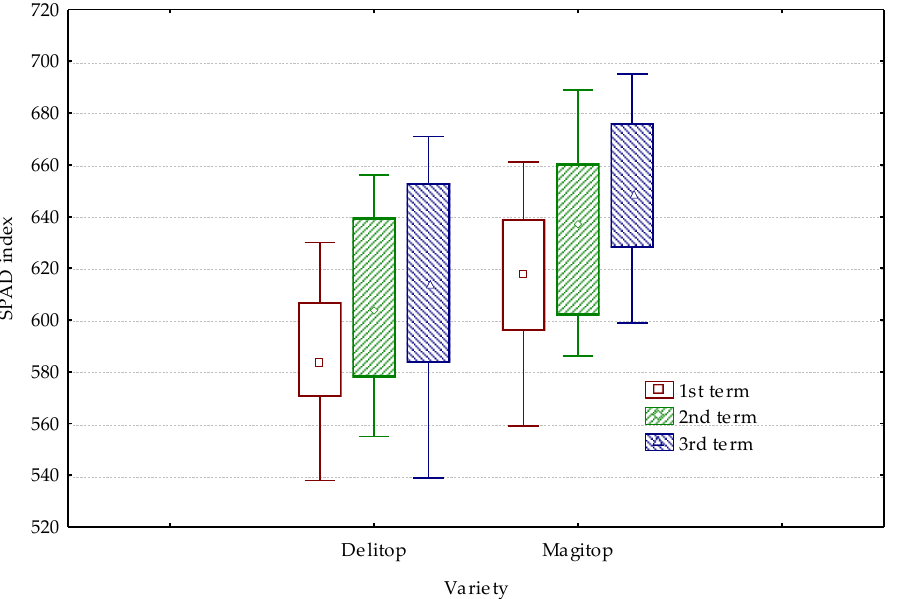
Figure 3. Boxplot of the SPAD index at successive measurement dates of in relation to maize